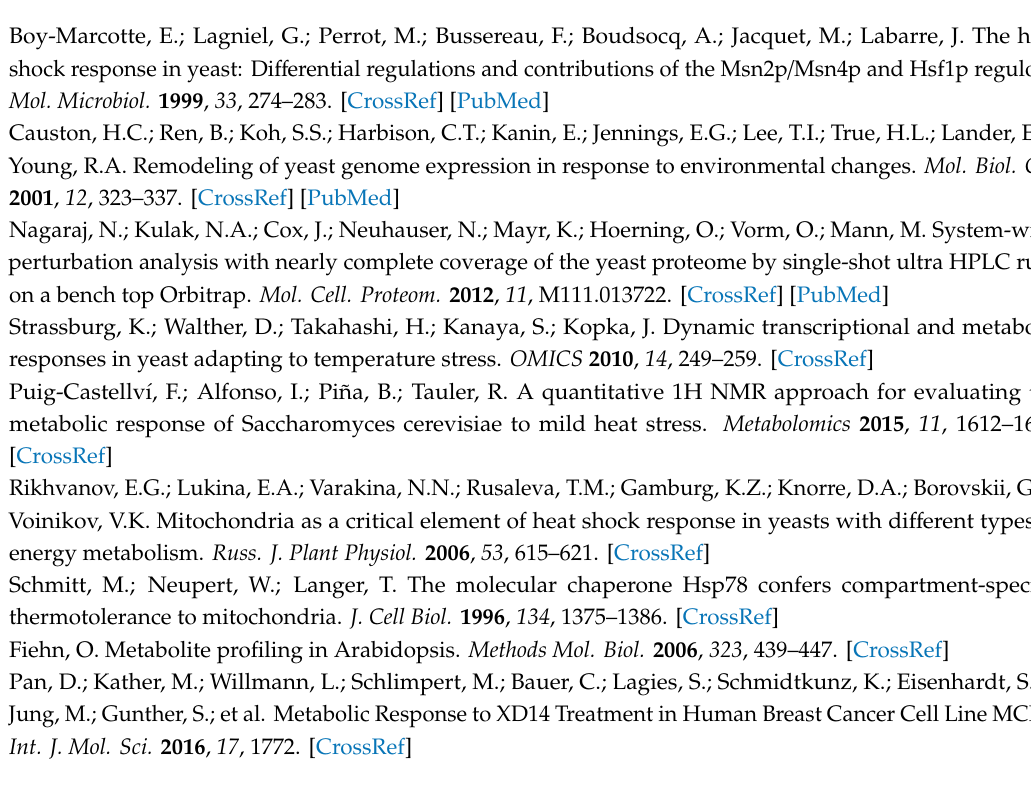
Table S1: PCA loading values for Figure 1, Table S2: MRM transitions of purine and pyrimidine metabolism, and amino acid metabolism, Table S3: data processing GC / LC-MS, Table S4: data of isotope labeling